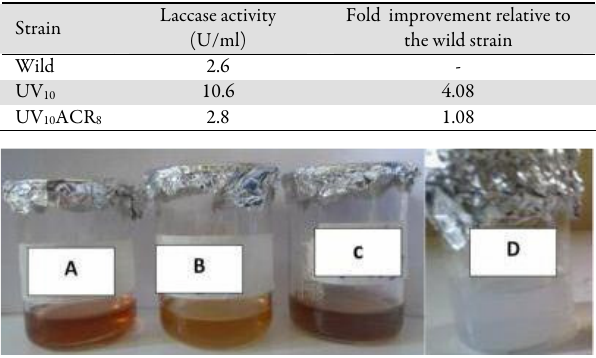
Fig. 1. Colour formation during the synthesis of AgNPs after 1 h of reaction (A- wild; B- UV